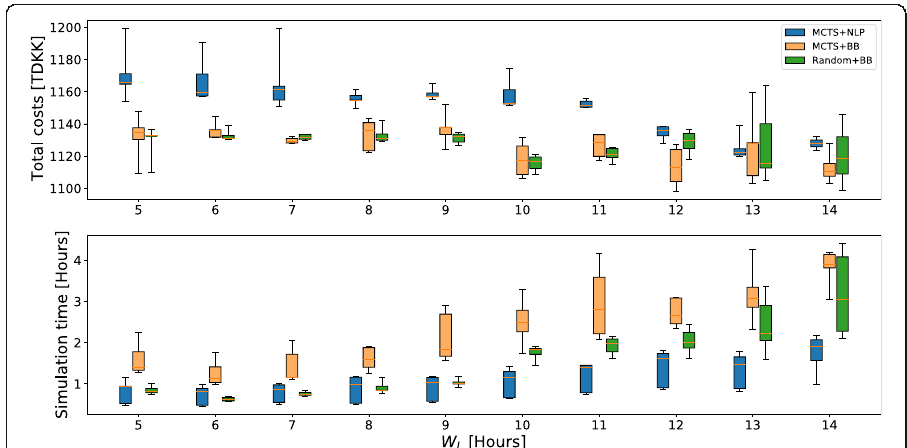
Fig. 9 Boxplot of objective function value (top) and simulation time (bottom) as a function of time window across 5 simulations for each